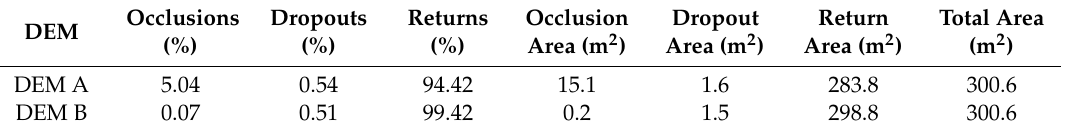
Table 1. Results of data gap classification for test site DEMs A and